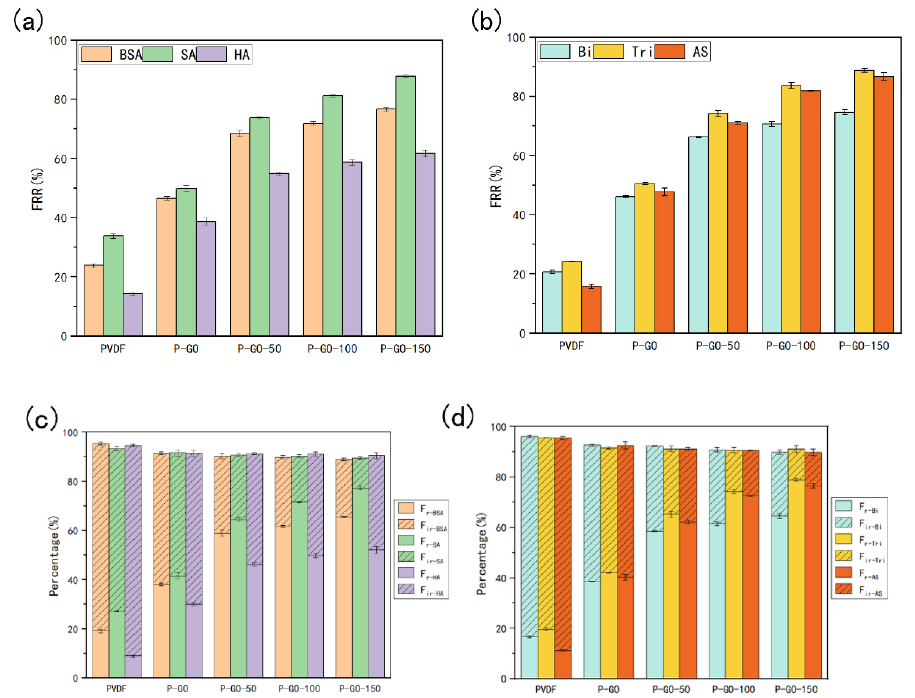
Figure 9. Flux recovery ratio ( FRR ), reversible flux decline ratio ( R r ) and the irreversible flux decline ratio ( R ir ) for different foulants during filtration experiments of original and prepared membranes. ( a , b ) FRR of the membranes; ( c , d ) R r and R ir of the membranes.